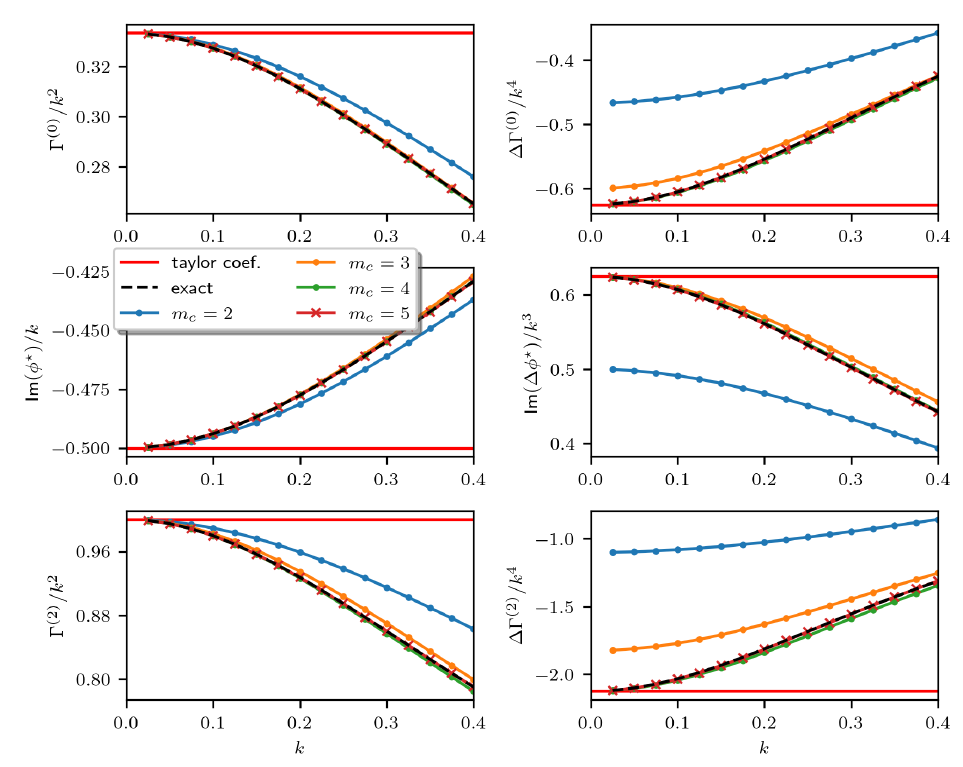
Figure 5: Taylor Coefficients from FRG in classical case. Definition of quantities the same as in figure 4.